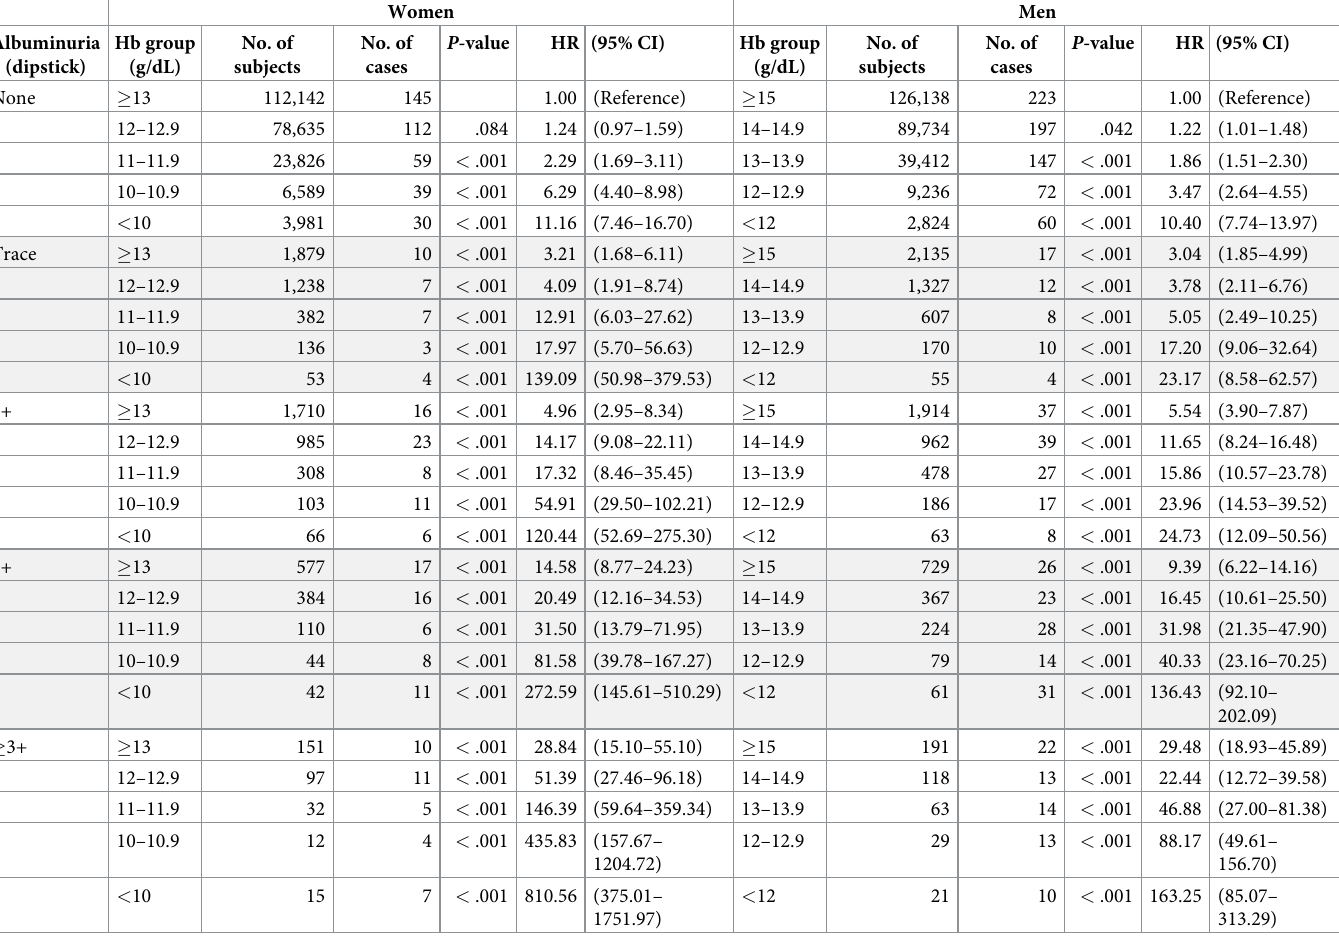
Table 2. HRs a for ESRD incidence in men and women in 25 combined Hb and albuminuria